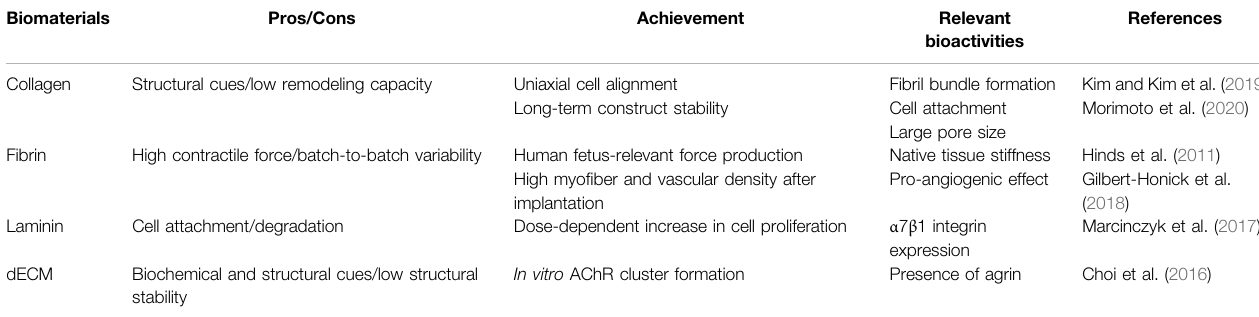
TABLE 1 | Different types of biomaterials used in skeletal muscle tissue engineering.